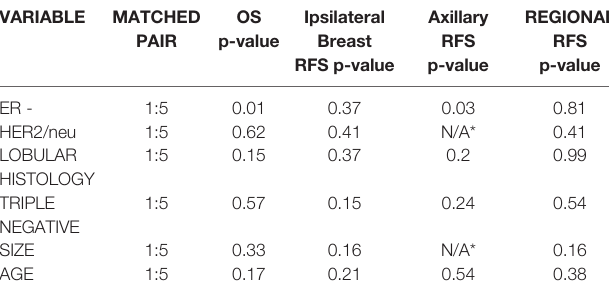
TABLE 5 | Matched pair